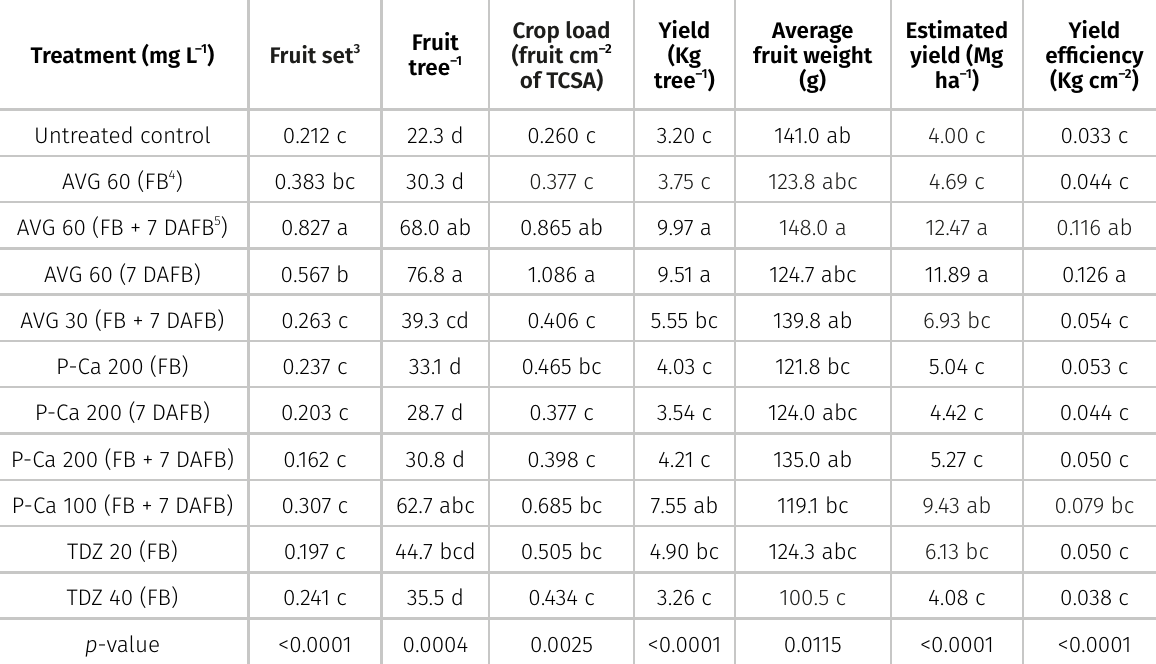
Table I. Fruit set, crop load, number of fruit per tree, yield, average fruit weight, estimated yield and yield efficiency of ‘Rocha’ pear trees treated with different rates and timings of aminoethoxyvinilglycine (AVG), prohexadione calcium (P-Ca) and thidiazuron (TDZ) in São Joaquim, SC, in the 2015/2016 growing season. 1